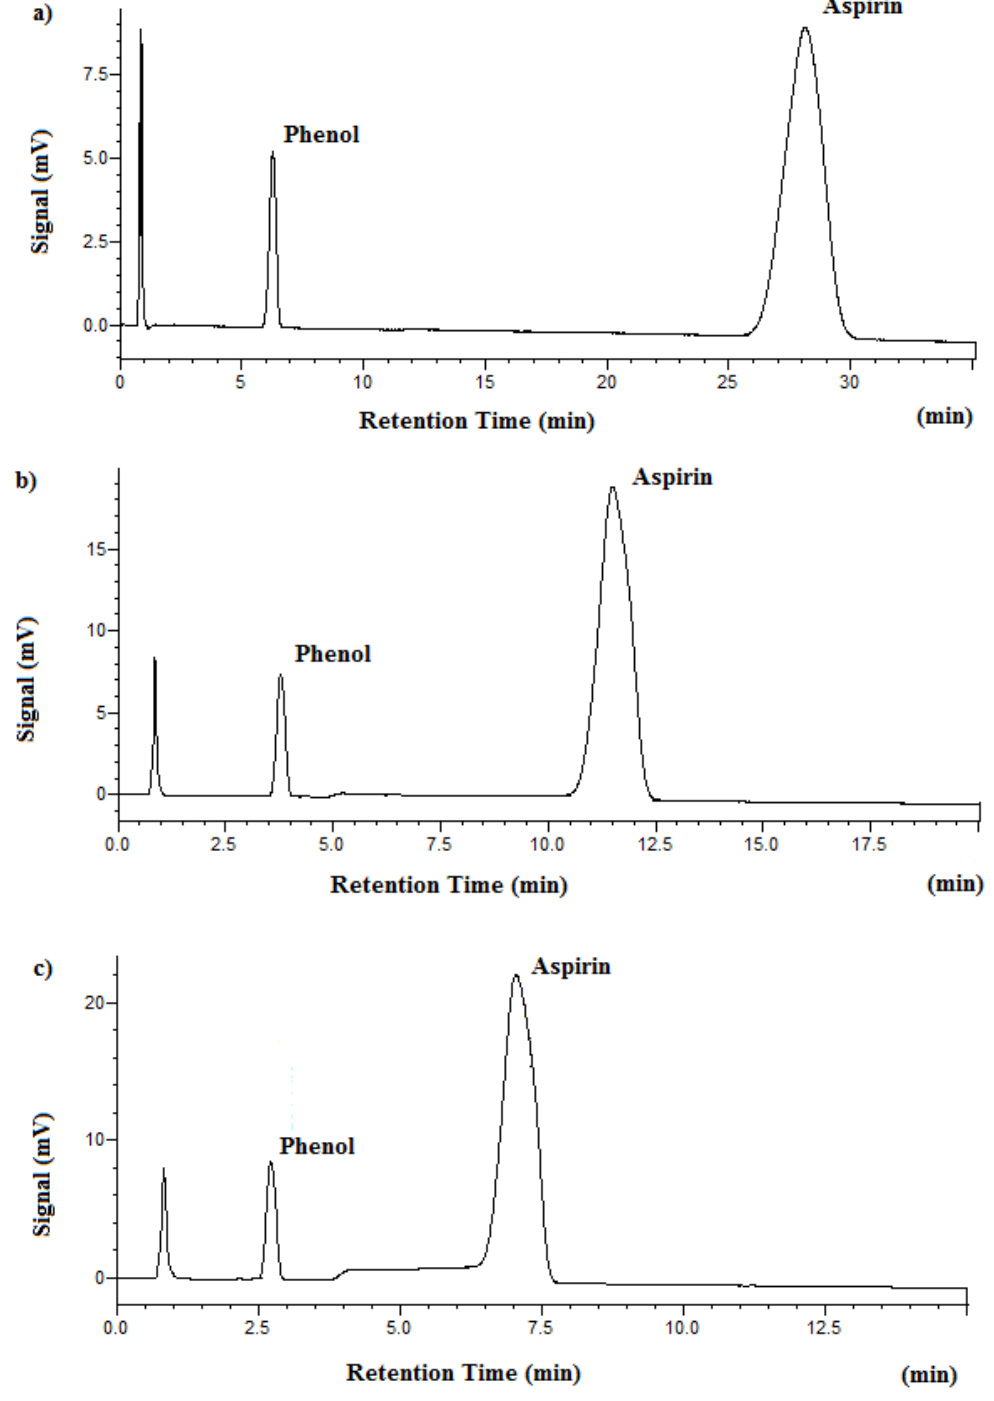
Figure 1. SBWC chromatograms of aspirin obtained on the XBridge C18 column with 1.5 mL/min and UV detection at 254 nm. Mobile phase was 100% phosphate buffer at pH 3.4. ( a ) 95 °C, ( b ) 125 °C, ( c ) 150 °C.